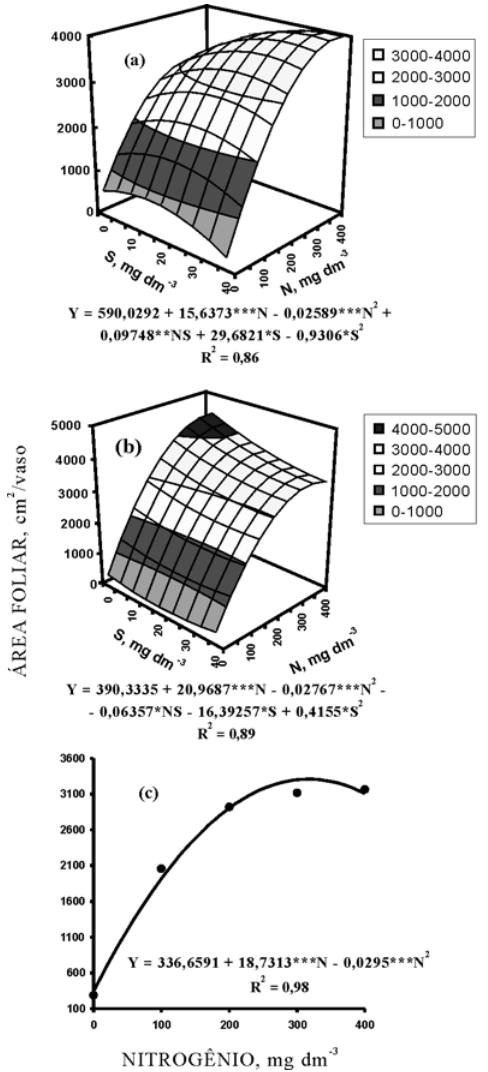
Figura 2. Área foliar do capim-braquiária no primei- ro (a) e no segundo (b) crescimento de acordo com a adubação com doses de nitrogênio e en- xofre, e no terceiro crescimento (c), consideran- do a adubação com doses de nitrogênio. *** ; ** e * : Significativo a 0,1; 1 e 5 %, respectiva-